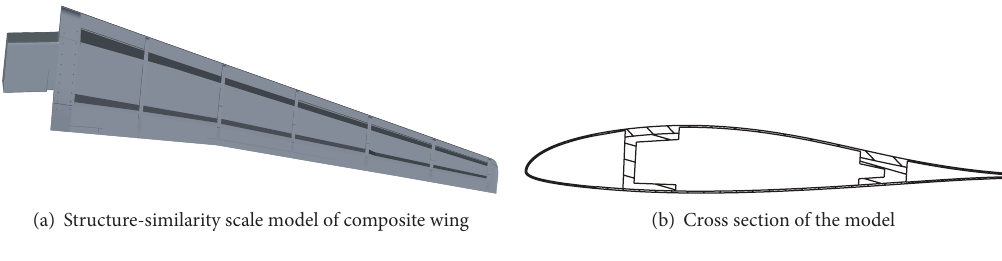
Figure 1: Structure-similarity scale model of composite wing and cross section of the model.